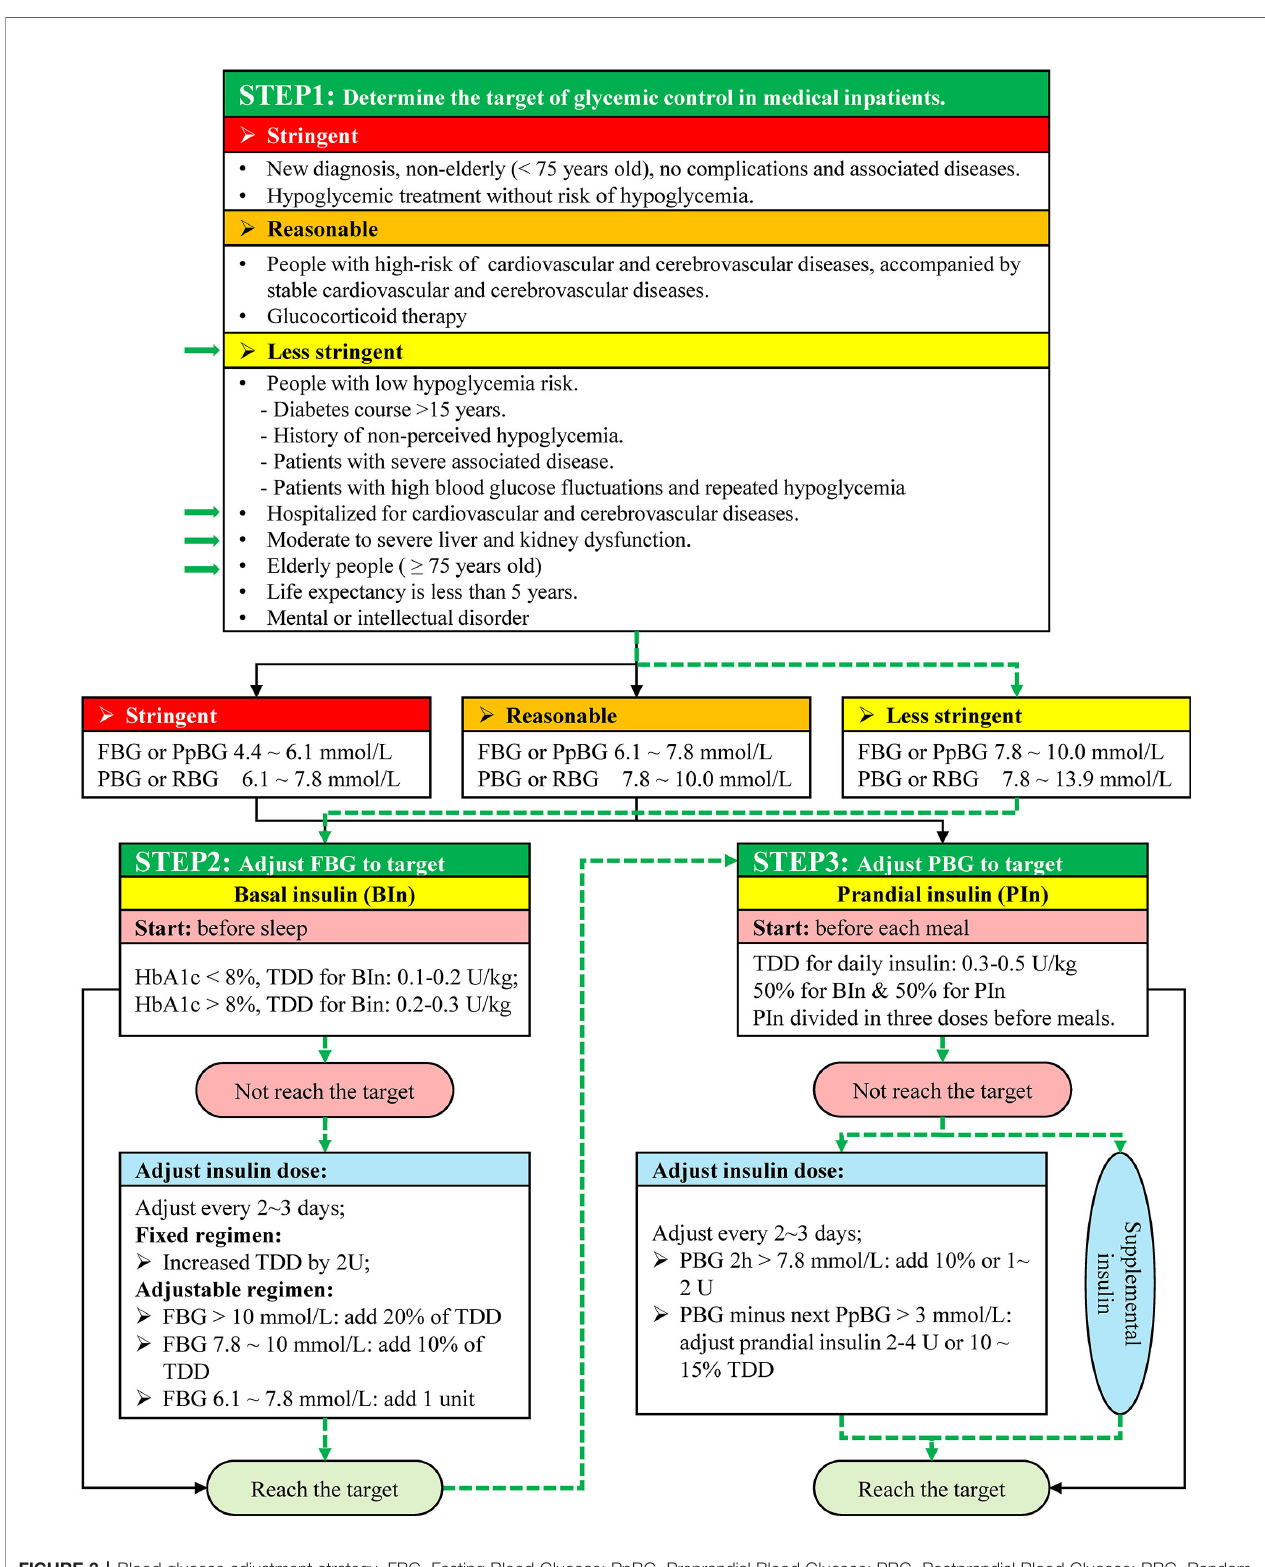
FIGURE 3 | Blood glucose adjustment strategy. FBG, Fasting Blood Glucose; PpBG, Preprandial Blood Glucose; PBG, Postprandial Blood Glucose; RBG, Random Blood Glucose; TDD, Total daily dose; HbA1c, glycosylated hemoglobin; BIn, Basal insulin; PIn, Prandial insulin. The green arrows indicate patient information and blood glucose adjustment in this